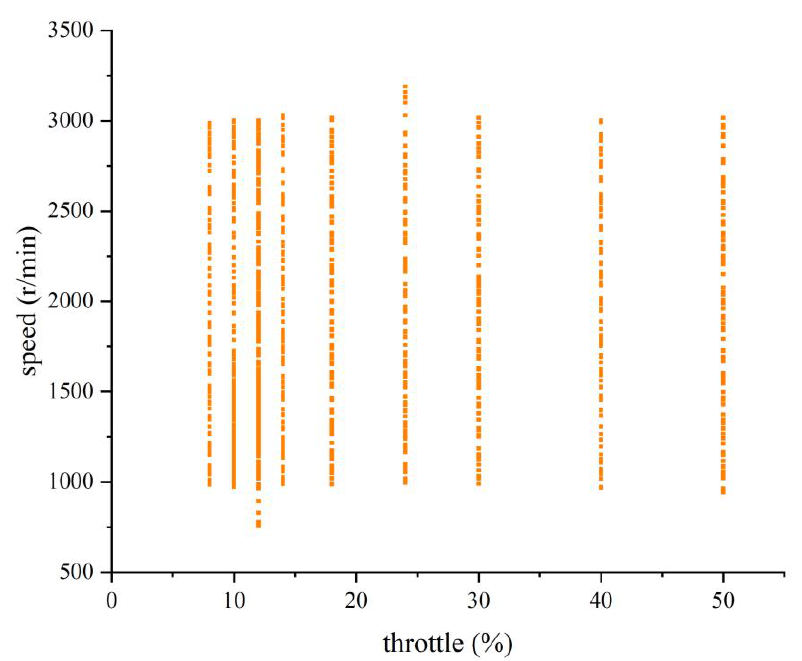
Figure 9. Engine operating envelop of the training set in terms of engine speed and throttle valve percentage.